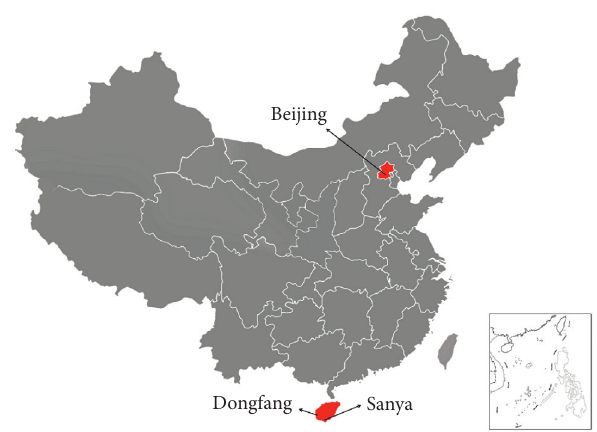
Figure 2: Location of Sanya, Dongfang, and Beijing on a map of